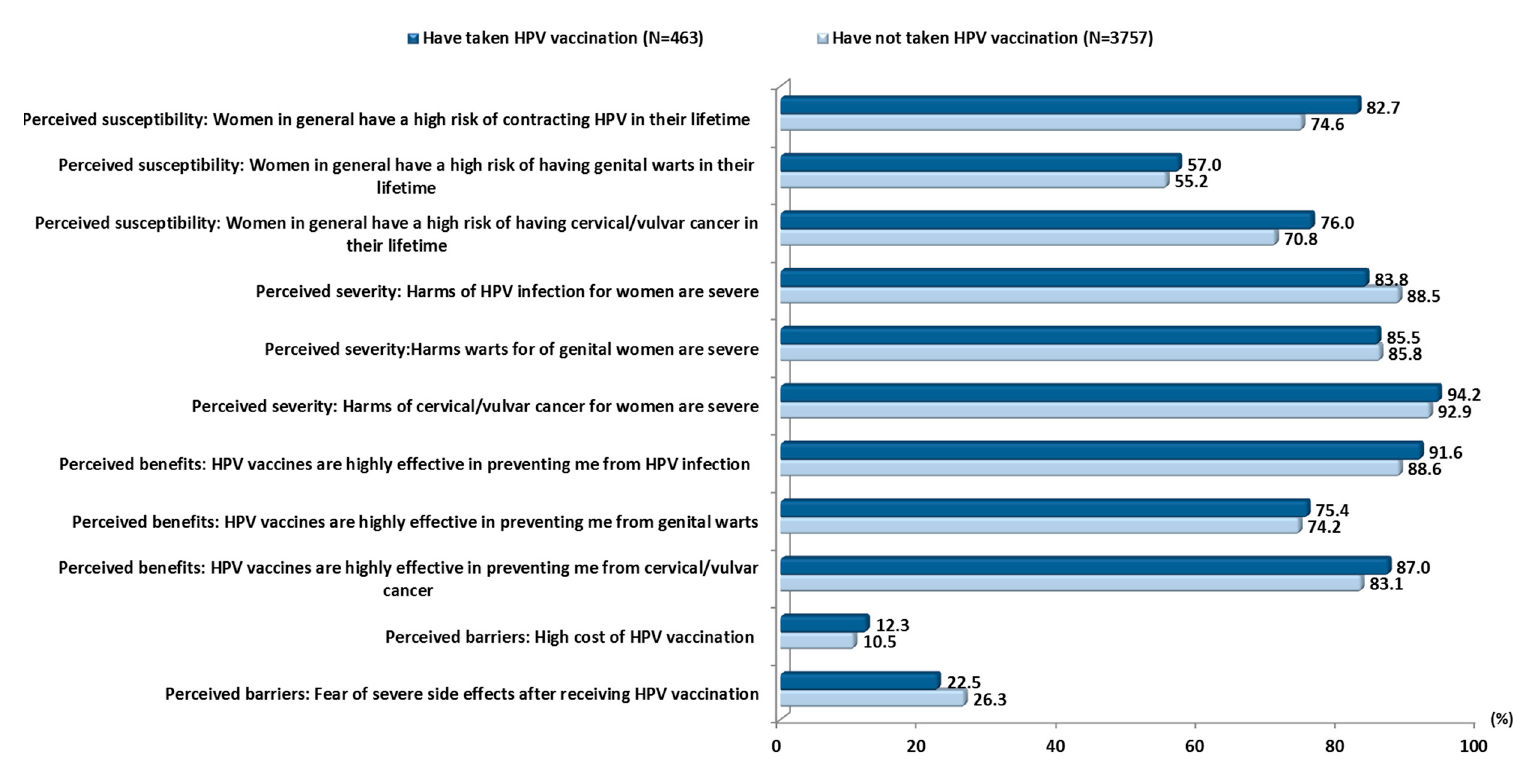
Figure 2. Differences in proportion of agreement to health belief statements among vaccinated and unvaccinated participants ( N = 4220).